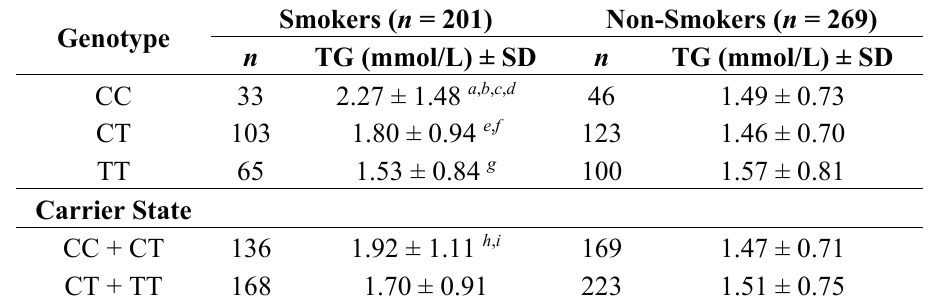
Table 6. Triglyceride (TG) serum levels in regard to genotypes of USF1 rs2516839 polymorphism in smokers and non smokers